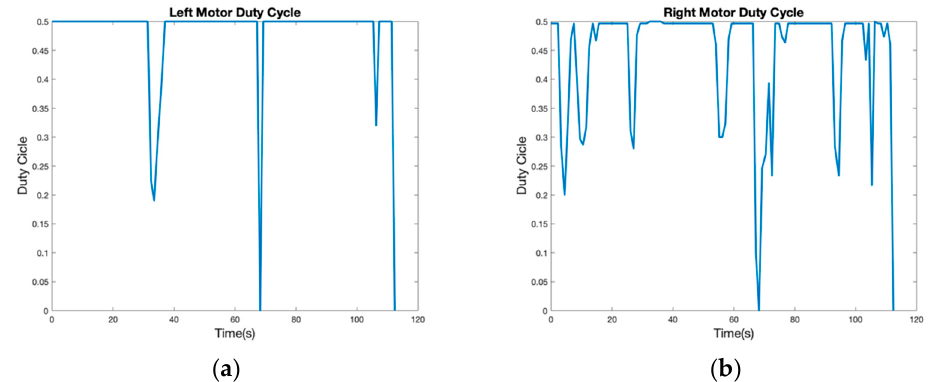
Figure 11. The motor control results: ( a ) Duty cycle for left motor and ( b ) duty cycle for right motor.